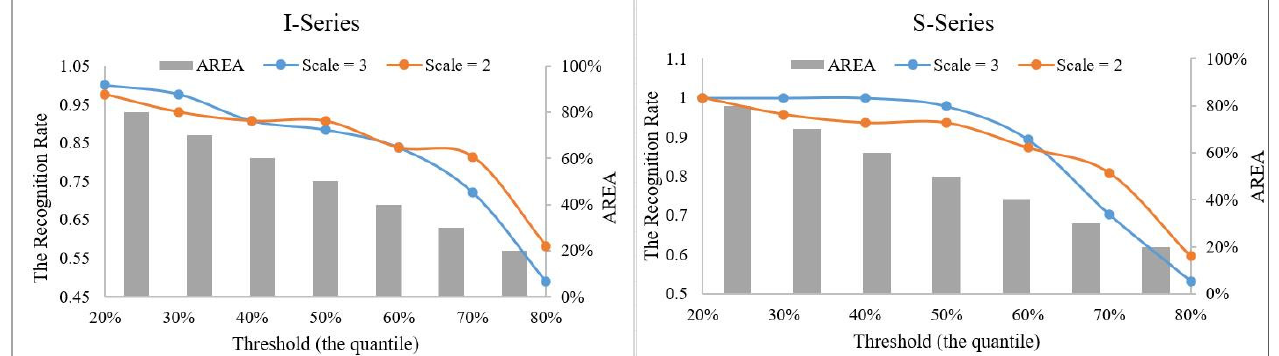
Figure 18. Plot of the recognition rate versus threshold and anomalous area. (left): the I-series elements; (right): the S-series elements.